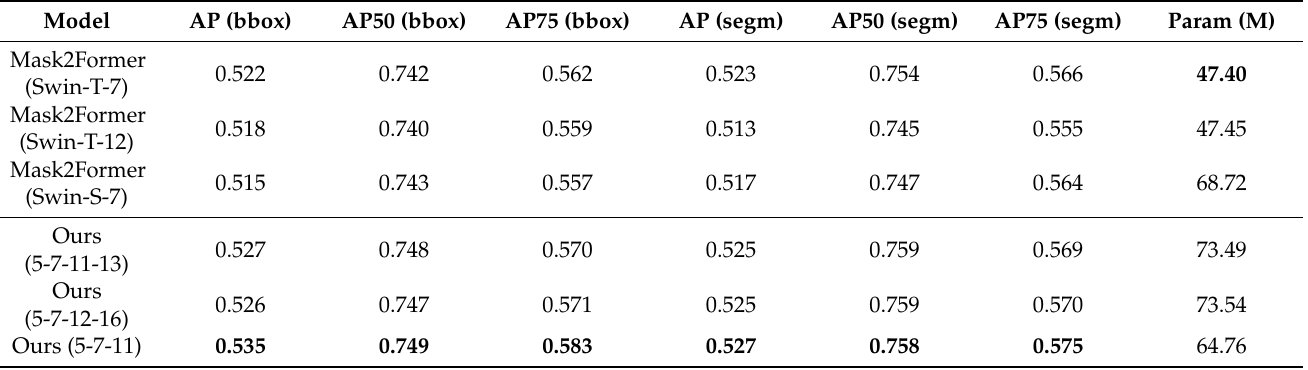
Table 3. Results of parallel connection of four scale windows, our results are still higher than baseline, but lower than those of our previous